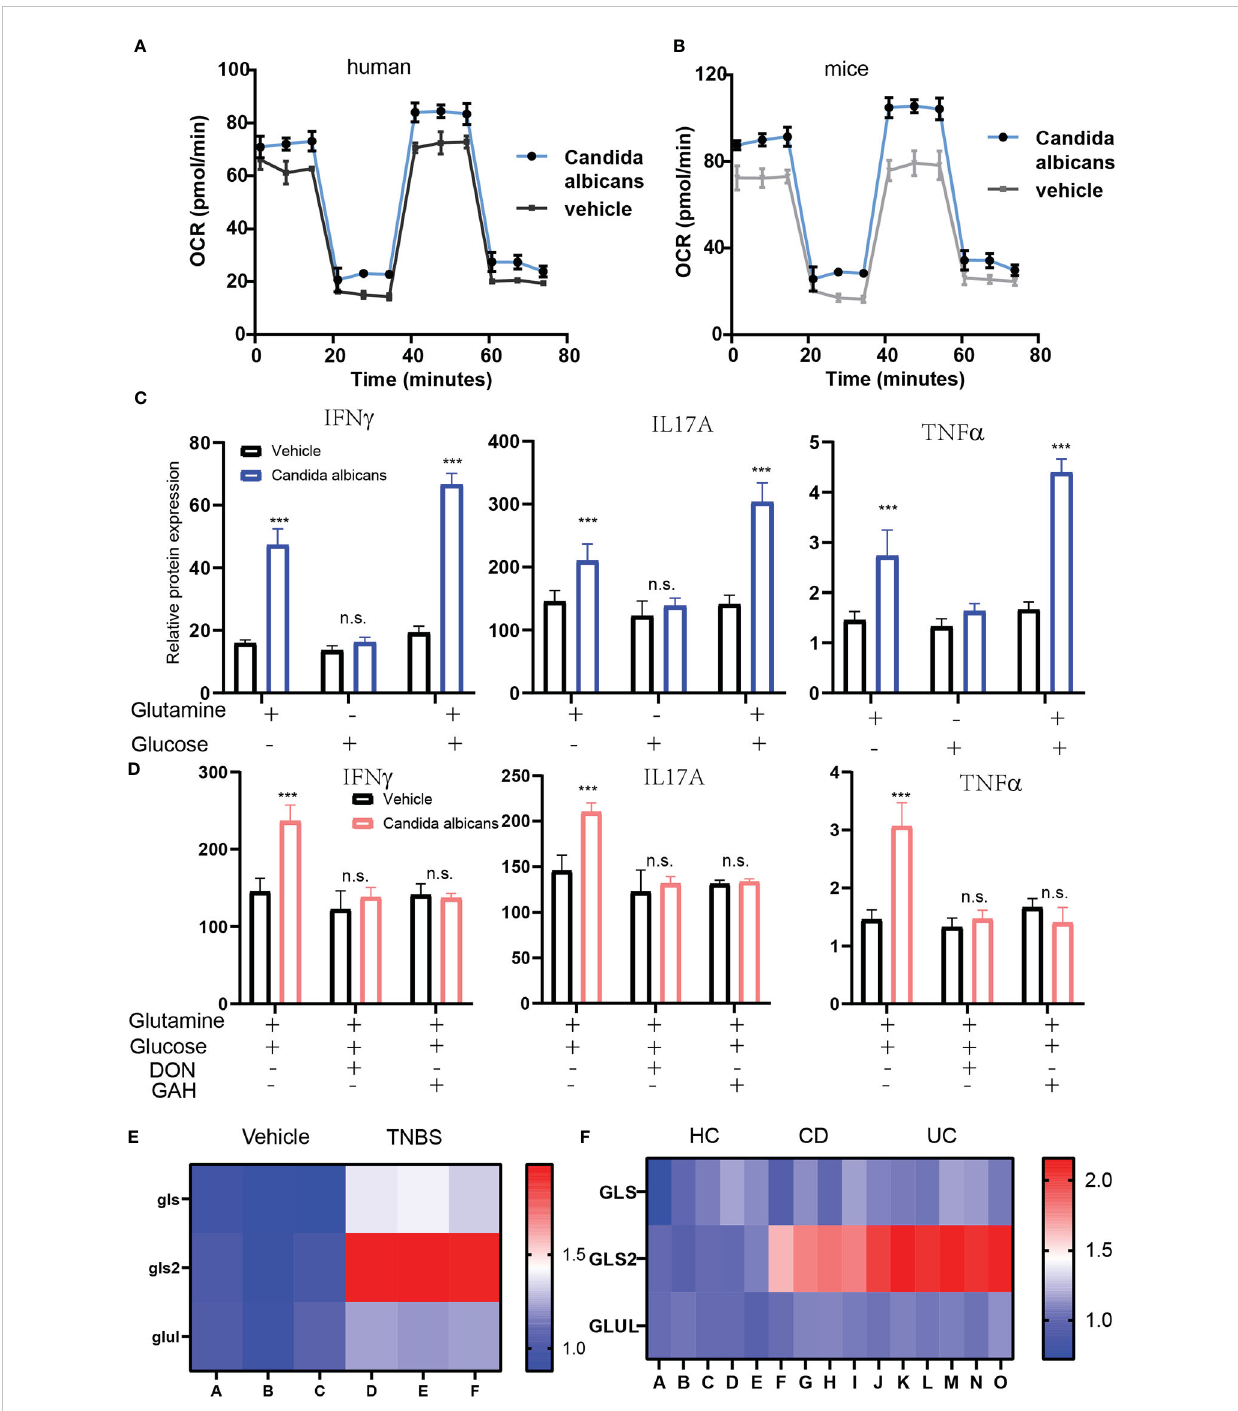
FIGURE 4 Enhanced glutaminolysis mediated by fungi infection is required for in fl ammation cytokines induction. (A, B) . The OCR level of CD4+ T cells isolated form human IBD (A) and mice (B) IBD that infected with fungi. (C) . The cytokines production of CD4+ T cells that supplemented with either 2mM glutamine, 10mM glucose or both. (D) The cytokines production of CD4+ T cells that blockage glutaminolysis with DON or GAH. (E, F) . The heat map of glutaminolysis genes expression in the fungi infected CD 4+ T cells. ***P < 0.001 and n.s., no signi fi cance P >